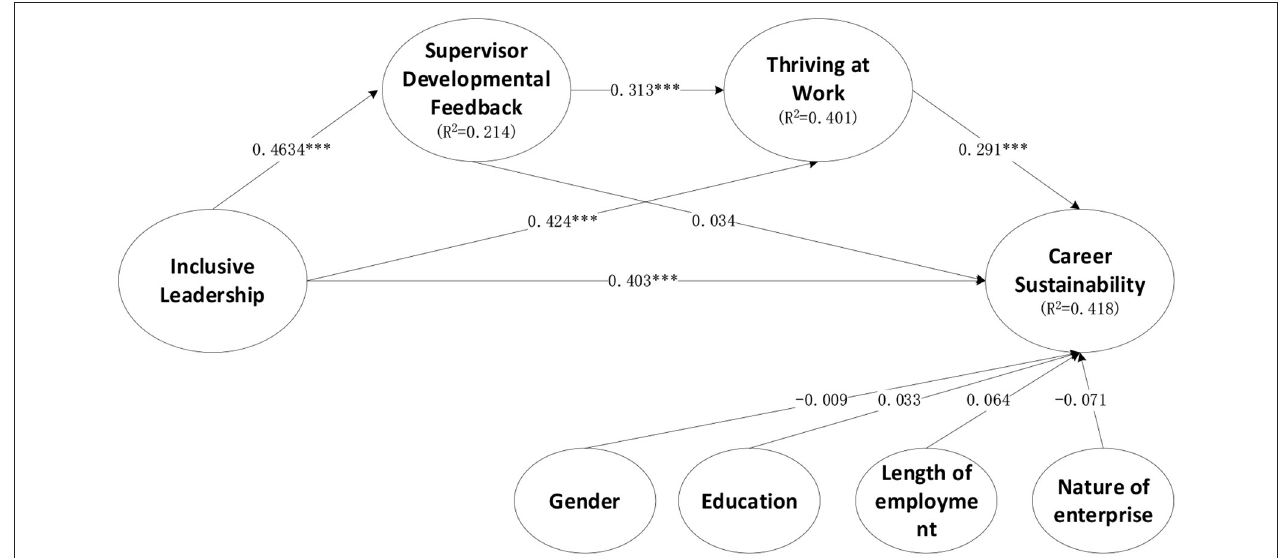
FIGURE 2 | PLS results of the research